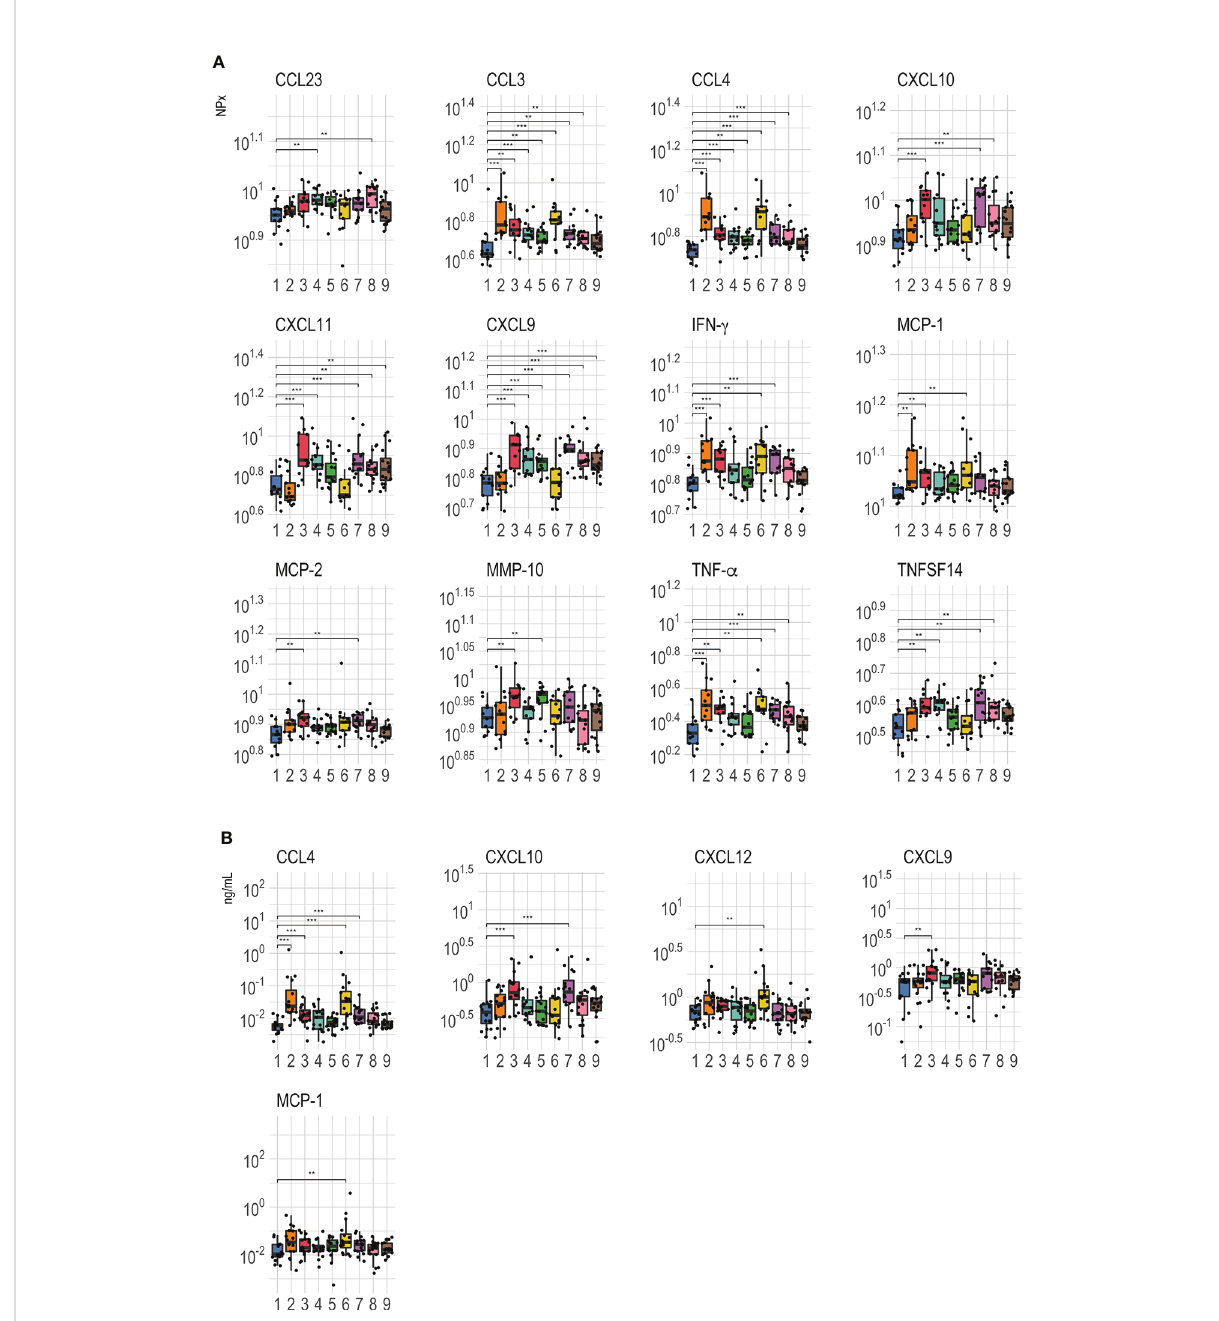
FIGURE 4 Comparison of abundance level between PrEP treatment arms. (A) shows Olink values compared between the control and PrEP arms including individuals according to the received drugs [FTC-TDF (2 – 5) or FTC-TAF (6-9)], the number of tablets [1 dose: 2 tablets (2, 3, 6, 7); two doses: 2 + 1 tablets (4, 5, 8, 9)] and the interval from the last dose to plasma sampling [5 hours (2, 4, 6, 8) or 21 hours (3, 5, 7, 9)]. (B) shows the Luminex values for the different arms.**=p < 0.01; ***=p <